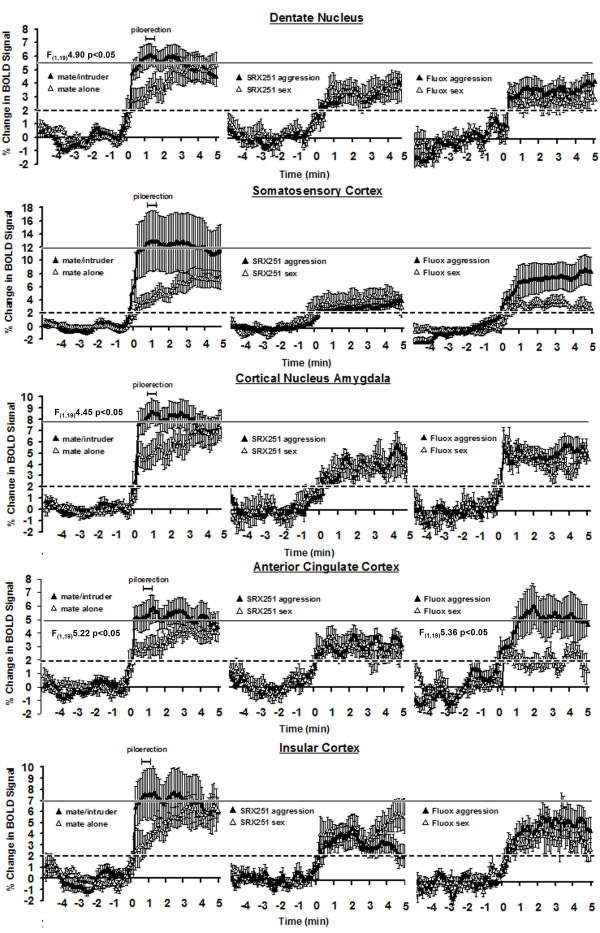
Change in BOLD signal in limbic cortical areas. See legend from figure 6.